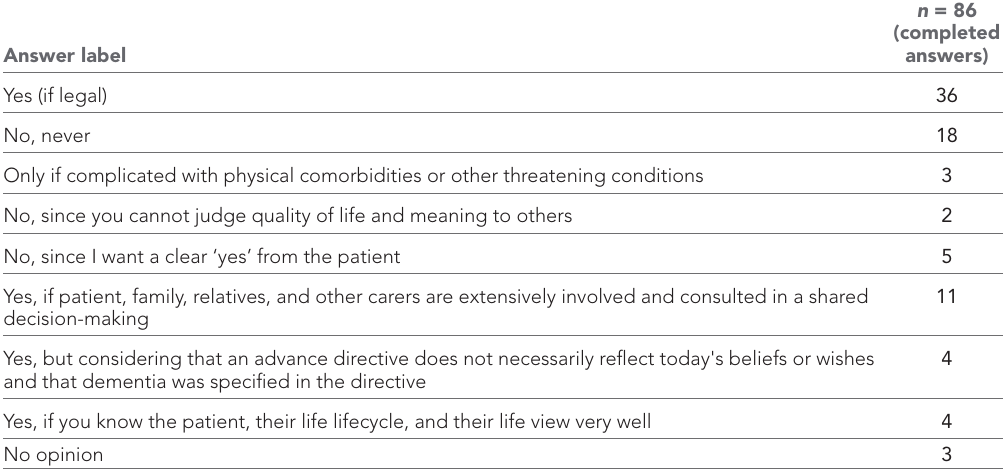
Table 3 Free- text comments to question: 'If legislation allows euthanasia in later than the beginning stages of dementia, would you carry out euthanasia (if advance directive available)?'